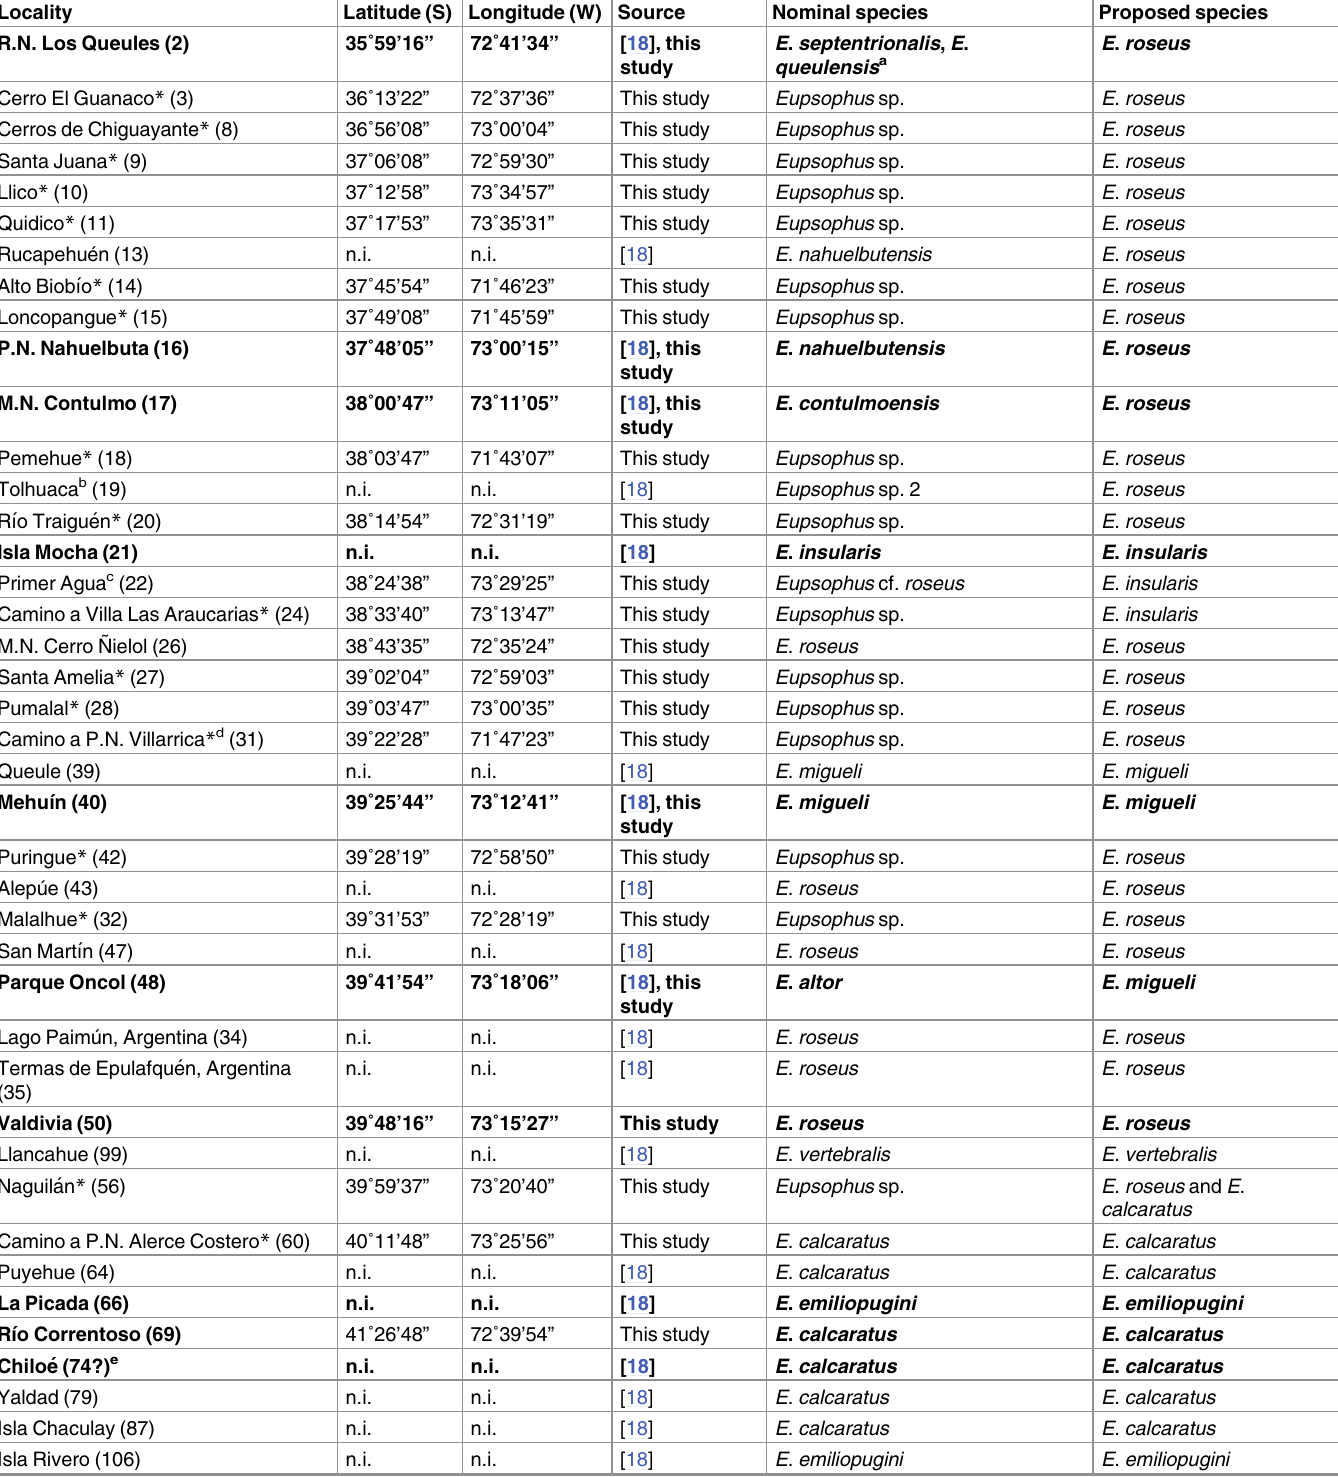
Table 1. Localities included in the phylogenetic analysis.